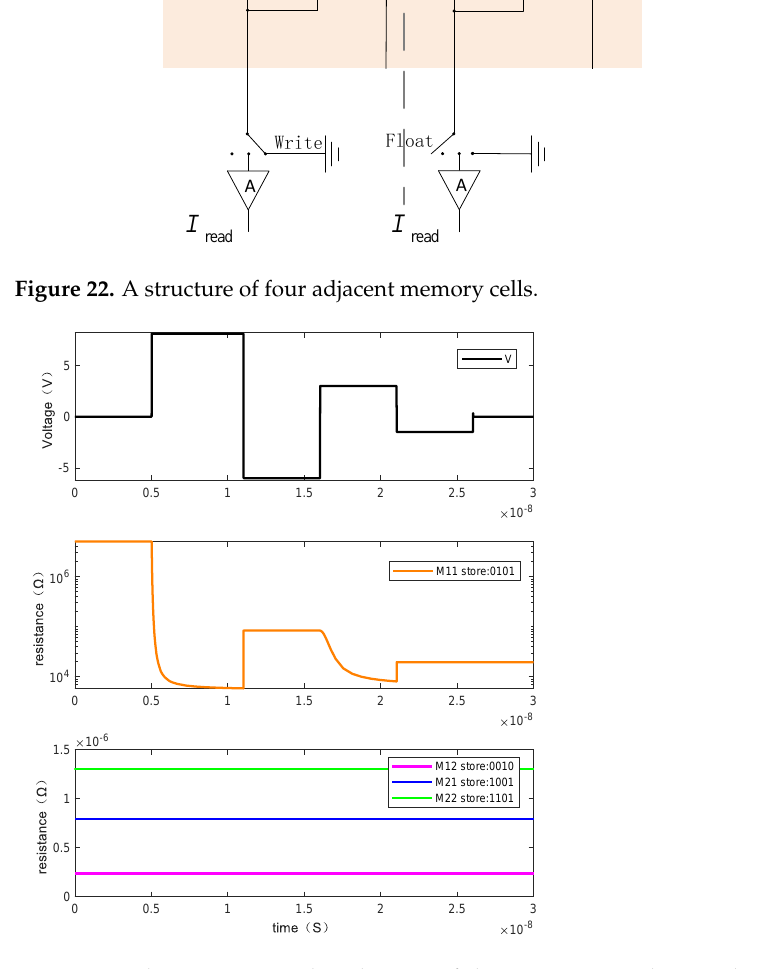
Figure 23. The resistance value changes of the M 12 , M 21 , and M 22 when writing “0101” to the memory M 11